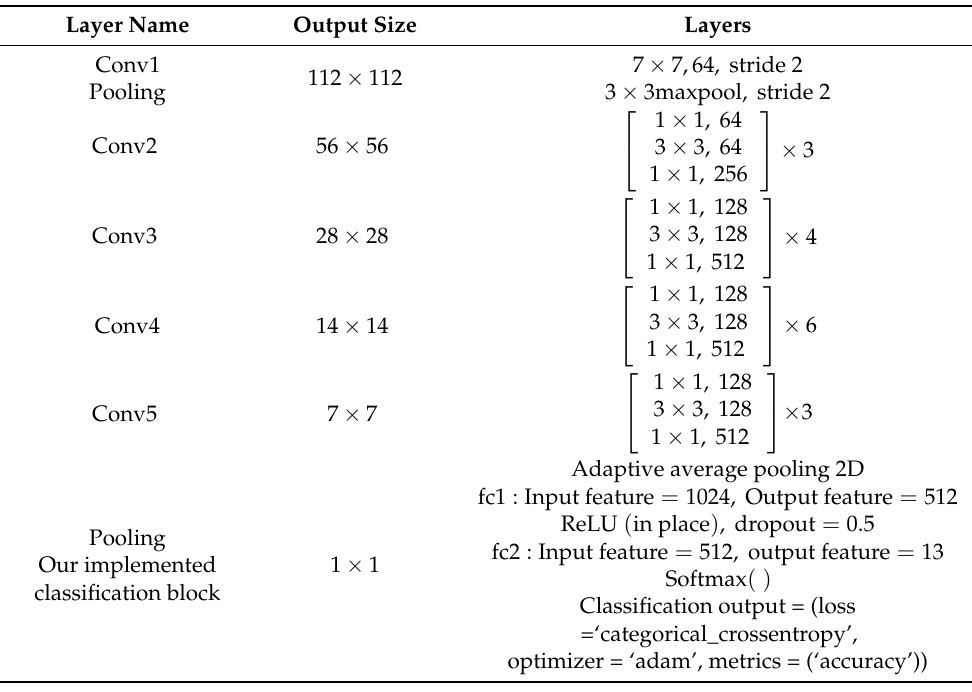
Table 2. Architecture of our proposed ResNet-50 pre-trained CNN